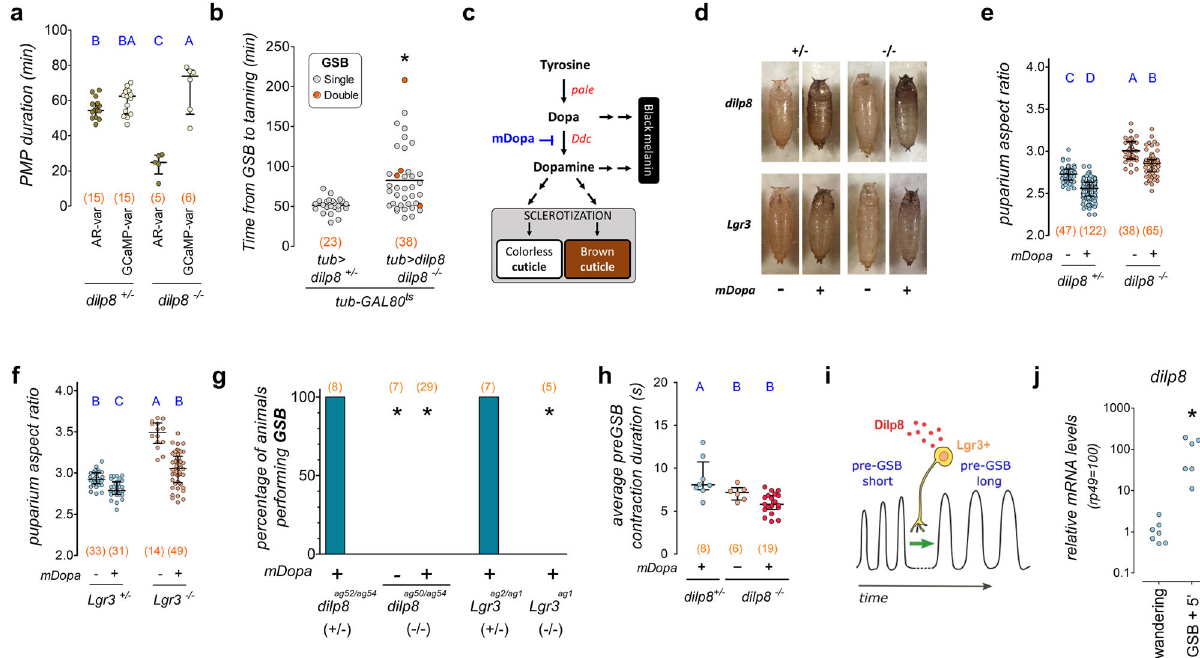
Fig. 6 Pupariation progression by coupling morphogenetic and neuromotor subprograms. a dilp8- mutant puparium aspect ratio (AR) fl uctuations are briefer than muscle calcium (mhc»GCaMP) fl uctuations during pupariation. Shown are dot plots of PMP duration in dilp8 mutants ( − / − ) and controls ( + / − ) according to variation in puparium AR (AR-var) or mhc»GCaMP (GCaMP-var). dilp8( − / − ) is dilp8 ag52/ag54 . dilp8( + / − ) is dilp8 ag52/ag54 . b Post-midthird instar transition-expression of tub > dilp8 delays tanning. Shown are dot plots of the time from GSB to tanning. Red dots, animals performing two GSBs. c Cuticle sclerotization and tanning pathway. mDopa, ɑ -methyldopa. d Photos of puparia. Effects of ɑ -methyldopa. e Quanti fi cation of d for dilp8 and f Lgr3 mutants and controls. Shown are dot plots of puparium AR. g ɑ -methyldopa treatment does not rescue GSB of dilp8 or Lgr3 mutants. Shown is the percentage of animals of the depicted genotypes that perform GSB. h ɑ -methyldopa treatment does not rescue the average duration of pre-GSB contractions of dilp8 mutants. Shown are dot plots of the average pre-GSB contraction duration. i Model for the Dilp8-Lgr3-dependent modulation of pre-GSB. j dilp8 mRNA levels increase 5min after GSB. Shown are qRT-PCR estimations of dilp8 mRNA levels in WT animals. Statistics (full details in Supplementary Table 2): a , b , e , f , j Dots: one animal. h Dots: average per animal. a , e , f , h Horizontal bar, median. Error bars, 25-75%. a , e , h Student – Neuwan – Keuls test. f Dunn ’ s test. b , j Mann – Whitney Rank sum test. g Binomial tests with Bonferroni correction. a , e , f-h Same blue letters, P >0.05. * P <0.05. (N) Number of animals